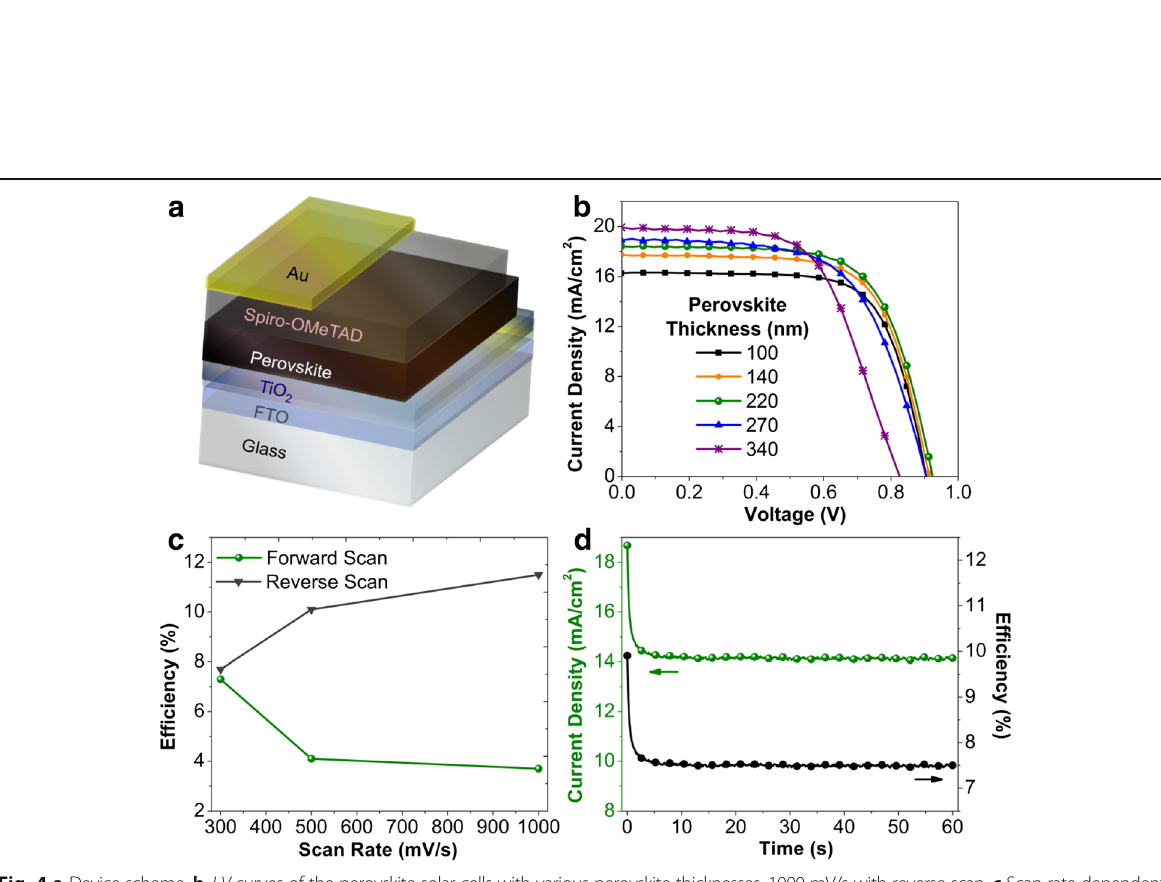
Fig. 3 SEM analyses of the 220-nm-thick perovskite layer. a Low magnification image. b High magnification image. c Histogram showing the grain size distribution. d Cross-sectional view